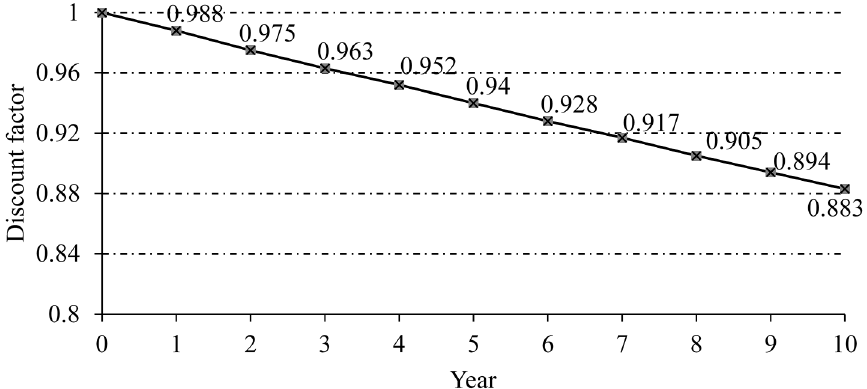
Figure 19. Discount factor for each year of the project lifetime.